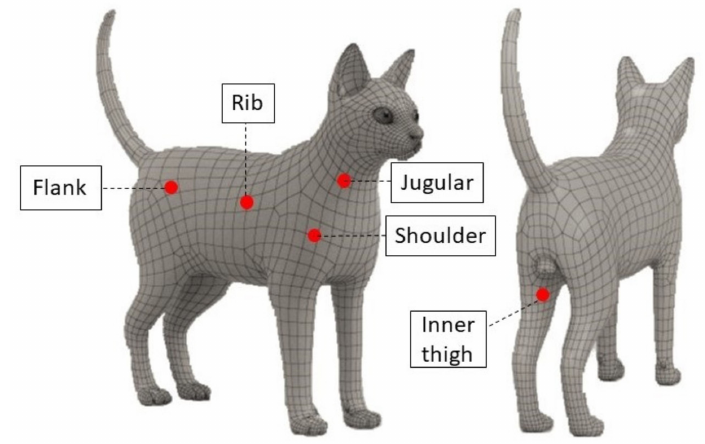
Figure 1. Graphical representation of measurement sites used for cutaneous temperature recording in cats. Jugular: the middle-third of the jugular vein; shoulder: the tip of the shoulder; rib: the middle-third of the chest, caudally to the heart area; flank: the dorsal portion of the flank, cranially to the iliac crest; inner thigh: caudally to the knee